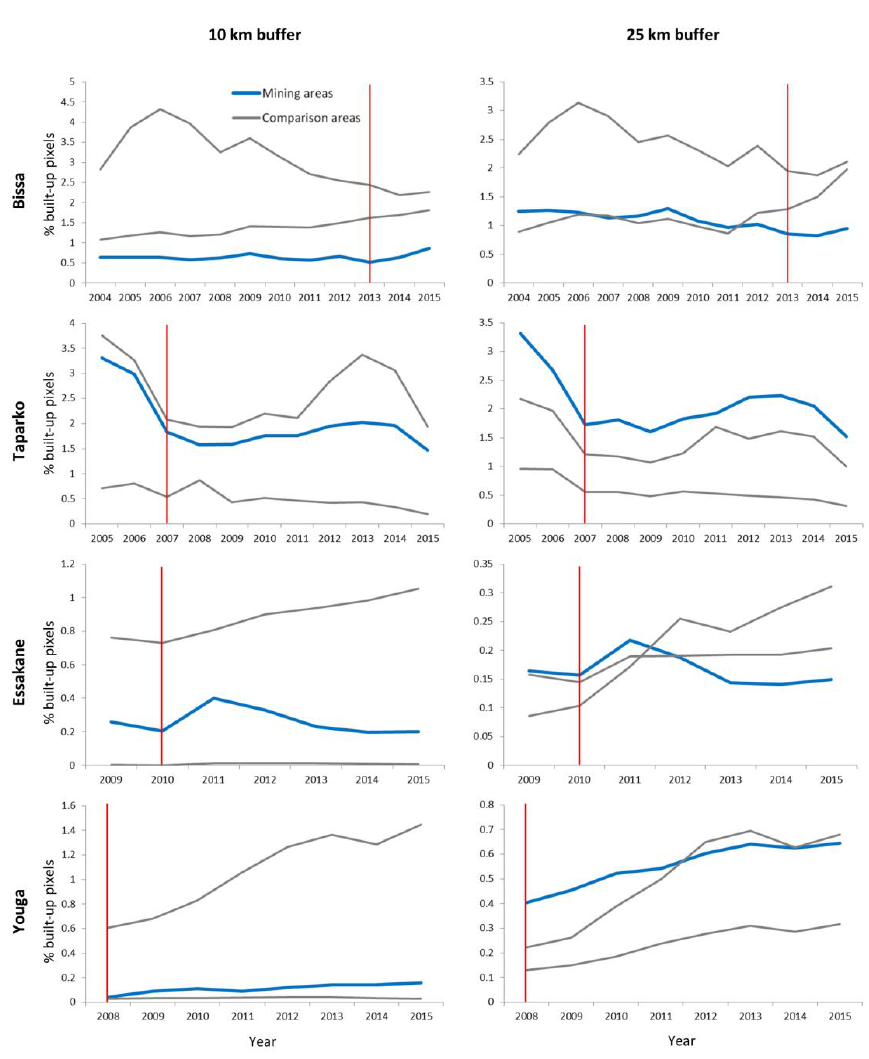
Figure 4. Comparison of the percentage of built-up pixels over time. Blue lines depict settlement growth in mining areas over time. Gray lines show settlement growth in comparable nearby districts within a 10 km (left panels) and 25 km (right panels) radius. Red vertical bars indicate the opening year of the mine.